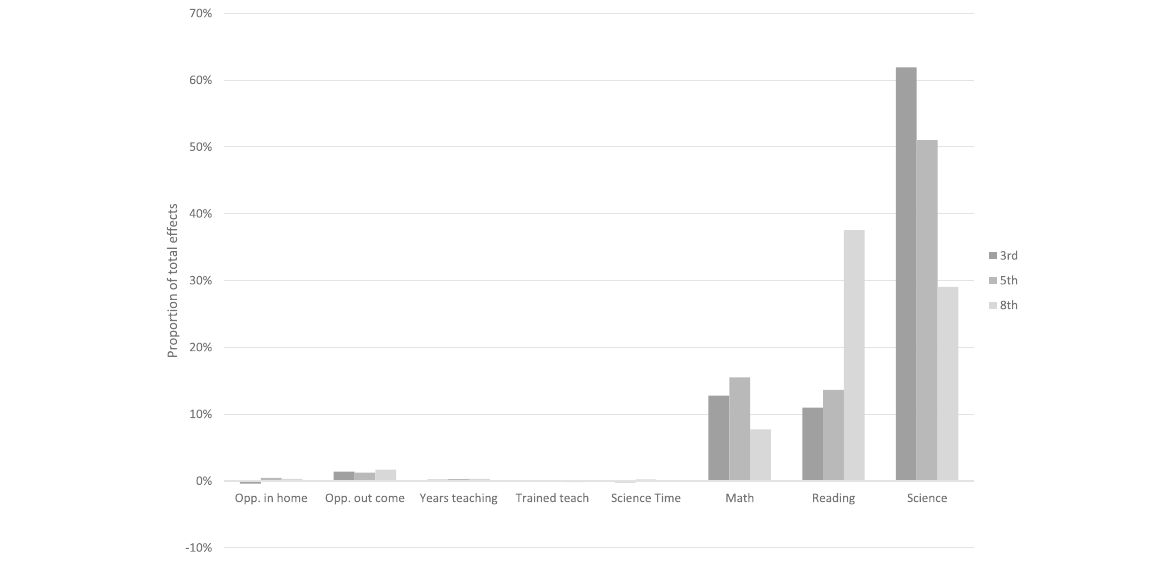
Fig. 2 Contributions of each mediator to the income gap in science achievement